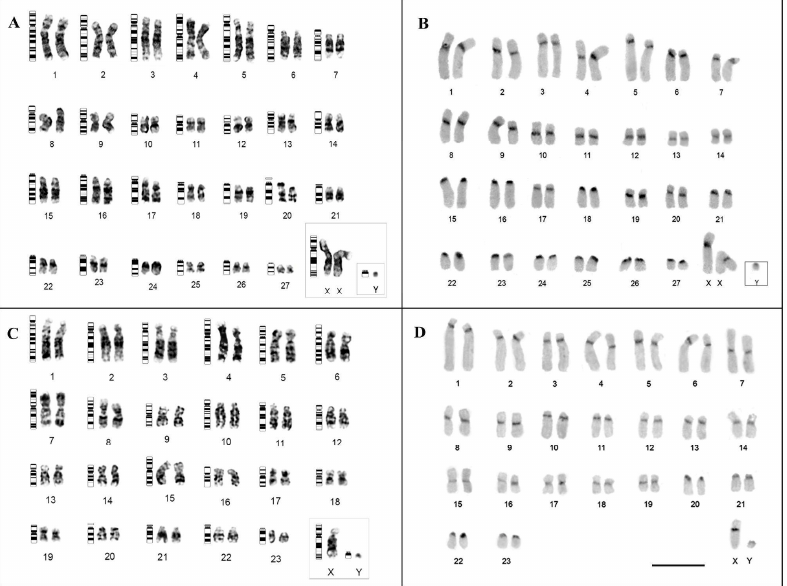
Figure 2. Comparative analysis by G-banding between TIN and TMM: ( A ) possible chromosomal homologies; and ( B ) possible chromosomal rearrangements. Bar 10 μ m. The karyotypes of probable hybrids were organized in accordance with TMM karyo- type. The individuals “Poque” and “Vitor” presented a distinct karyotype from the TIN and TMM species, with 2n = 50 (Figure 3). “Poque” showed NFa = 88, composed of 20